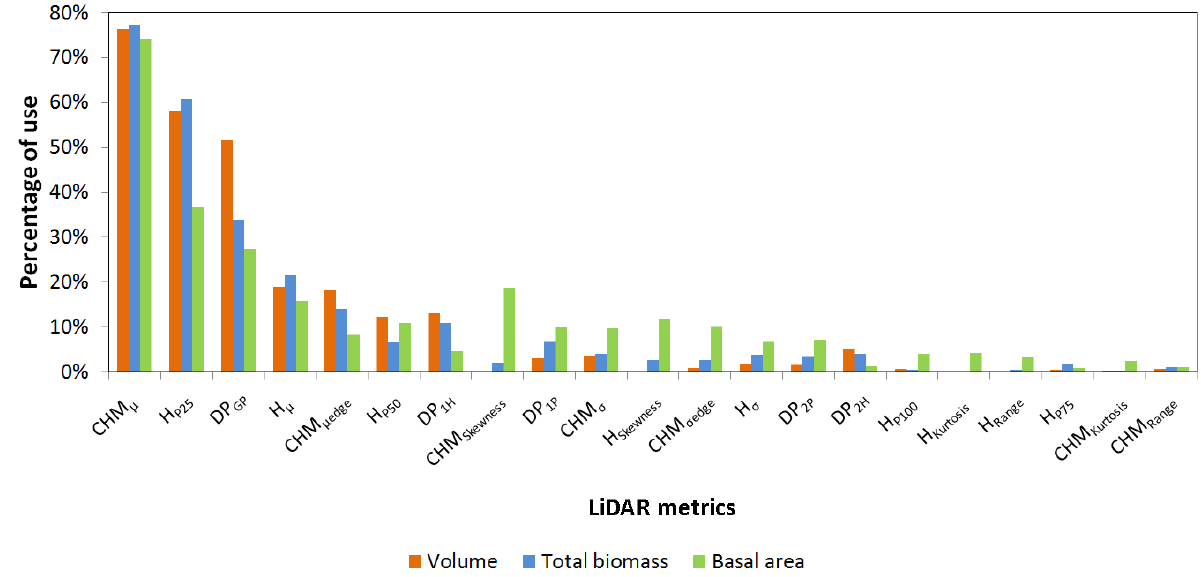
Figure 4. Percentage of use of LiDAR-based metrics in the prediction models of volume, total biomass, and basal area obtained using different parameter